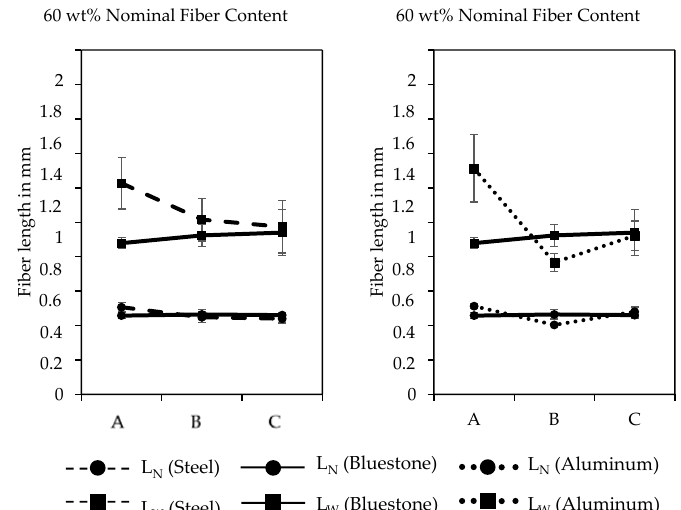
Figure A6. Fiber length (N = number average; W = weight or length average) for different tool types (for better representation in two diagrams) with 60 wt.% nominal fiber content at different specimen locations A, B, and C in accordance with Figure 7.